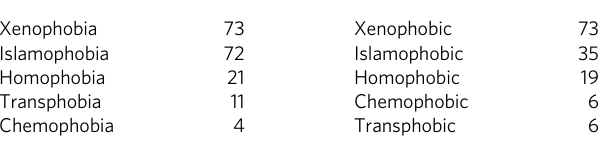
Table 1 Frequency counts for . *phobi[ac] .